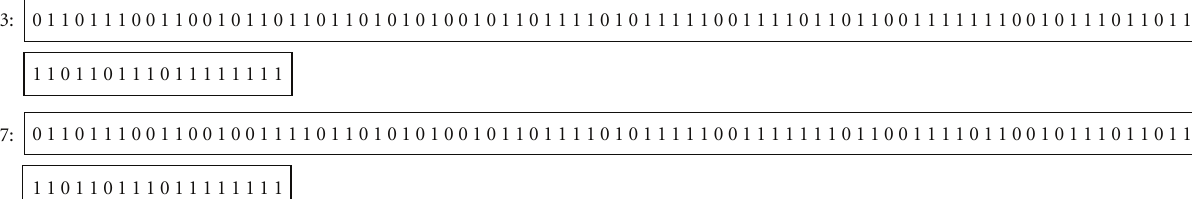
F 5: Best solutions in the decision variable